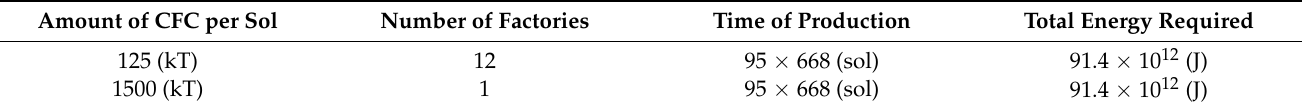
Table 5. Energy required for greenhouse gasses production on